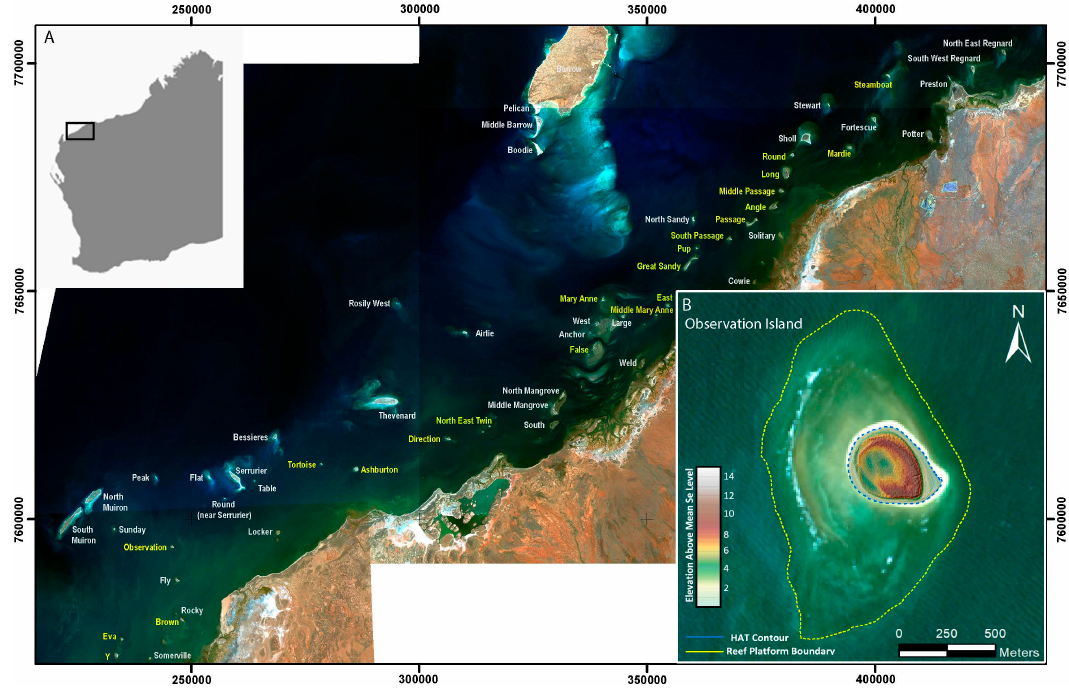
Figure 1. ( A ) Map of Pilbara islands; those 22 islands examined in the study are labelled yellow. ( B ) Example digital elevation model (DEM) of Observation Island showing highest astronomical tide (HAT) contour (blue dashed line) and reef platform area (yellow dashed line). White area around contour line is subaerial sand captured in the satellite image, but not captured by LiDAR due to tidal level at time of flight. Coordinates reported in UTM Zone 50, axis in meters